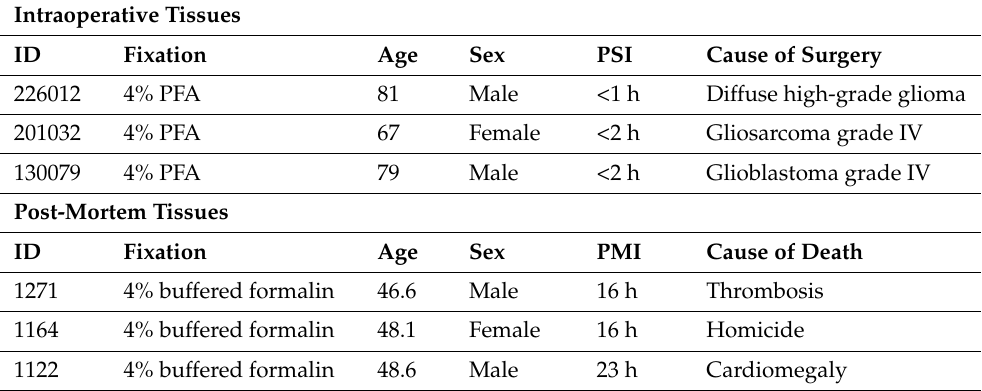
Table 7. Origin of human